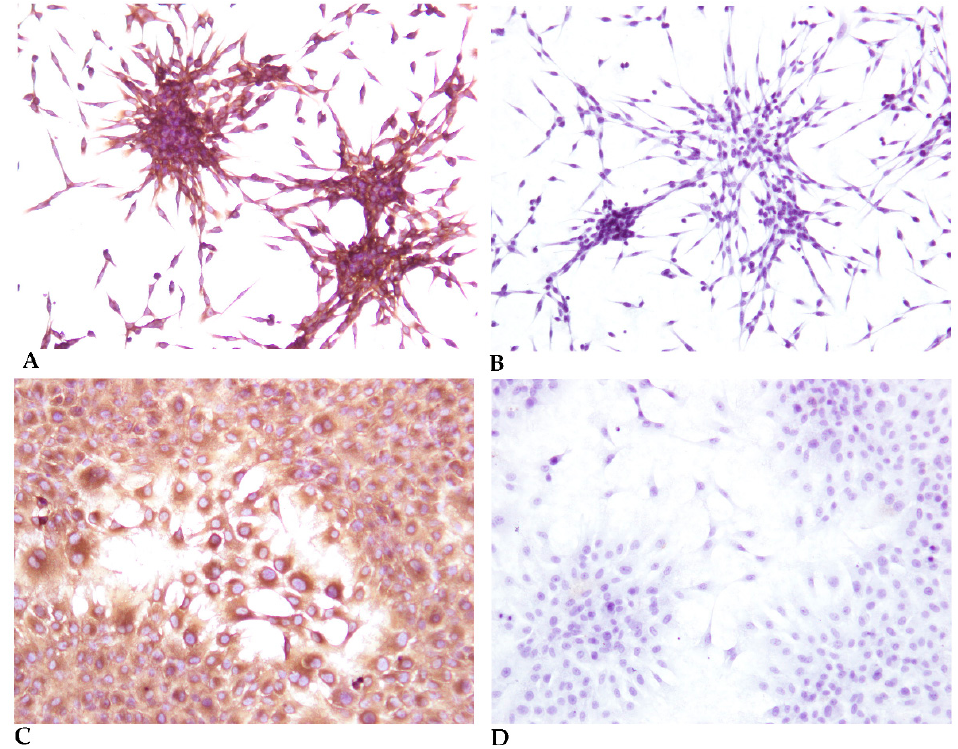
Figure 4. Immunocytochemistry of the third passage (subculture) ( A ) Immunocytochemistry using an anti-Vimentin Clone V9 antibody, of a 20% confluent culture, showing typical spindle cell morphology, 40×; ( B ) Immunocytochemistry using an anti-Cytokeratin AE1/AE3 antibody, of a 20% confluent culture, showing typical spindle cell morphology, 40×. Cells were fixated at lower confluence to allow a better observation of the cell morphology. ( C ) Immunocytochemistry using an anti-Vimentin Clone V9 antibody, of a 70% confluent culture, 100× ( D ) Immunocytochemistry using an anti-Cytokeratin AE1/AE3 antibody, of a 70% confluent culture, 100×.